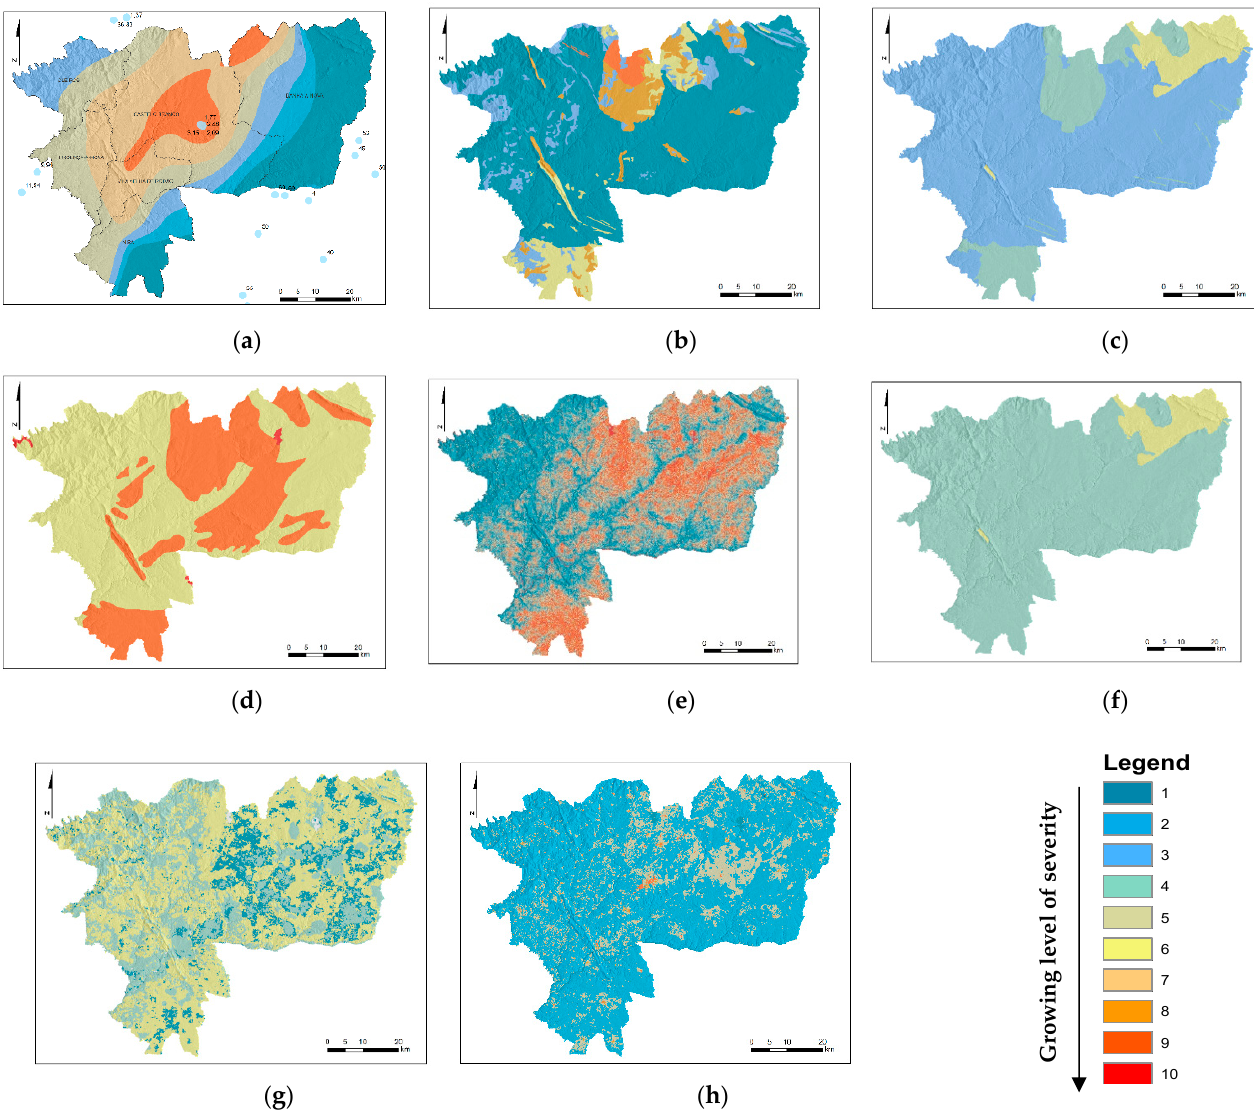
Figure 3. DRASTIC and DRASTICAI layer attributes: ( a ) depth; ( b ) recharge; ( c ) aquifer media; ( d ) soil media; ( e ) topography (slope); ( f ) impact of the vadose zone; ( g ) hydraulic conductivity; and ( h ) anthropogenic influence.